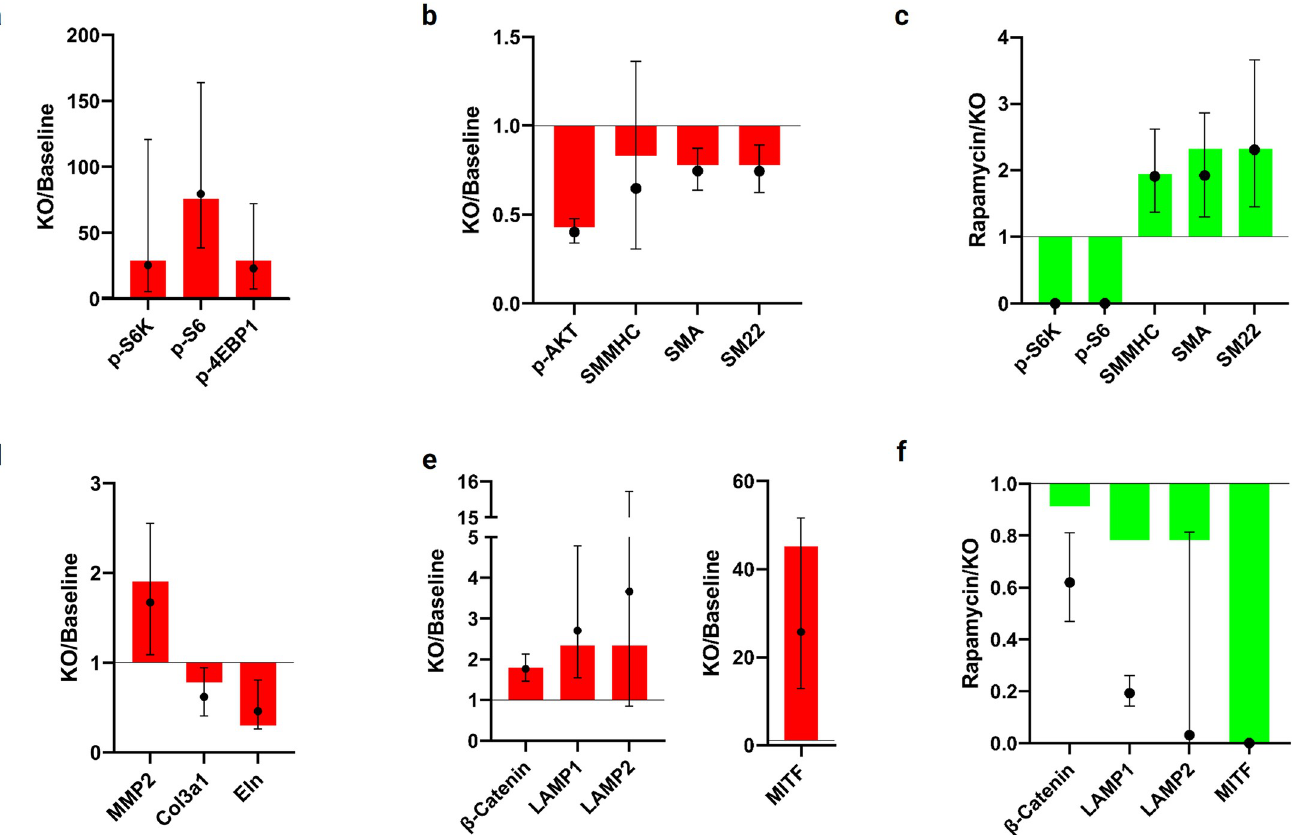
Fig 3. Quantitative comparison between network model results (bars) and experimental data (shown as point estimates (filled black circles) and 95% credible intervals (error bars) for the ratio of median expressions in KO versus baseline) reported by Li et al. [10]. a) The signaling network model quantitatively captured increases in expression of mTORC1-associated species (p-S6K, p-S6, and p-4EBP1) caused by Tsc1 knock-out. b) The network model quantitatively captured the decrease in p-AKT and contractile proteins (SMMHC, SMA, and SM22) caused by Tsc1 KO. c) Simulated inhibition of mTORC1 with rapamycin quantitatively captured the decrease in p-S6K and p-S6 activation and the decrease in contractile proteins observed experimentally. d) The network model quantitatively captured the increase in MMP2 expression and decrease in extracellular matrix transcripts Col3a1 and Eln seen experimentally after Tsc1 KO. e) The network model quantitatively captured the experimentally measured increases in lysosome-related proteins ( β -catenin, LAMP1/2, and MITF) due to Tsc1 KO. f) Inhibition of mTORC1 with rapamycin caused a decrease in lysosome-related species, which the network model captured qualitatively but not quantitatively. See Methods for details on the re-analysis of the experimental data from the